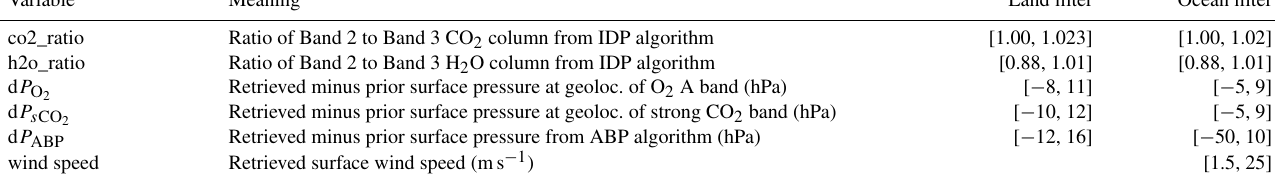
Table 5. Filter variables and limits for the X CO Variable